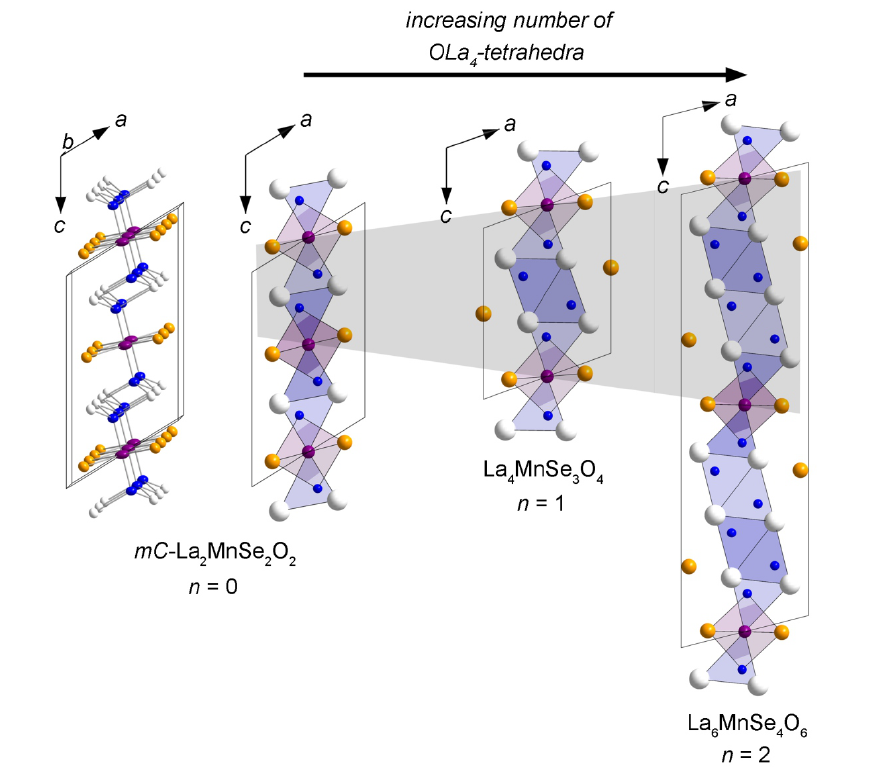
Figure 2. Crystal structures of La 2 n +2 MnSe n +2 O 2 n +2 ( n = 0–2). OLa 4 - and OLa 3 Mn-tetrahedra in blue, MnSe 4 O 2 -octahedra in violet. Rare-earth in white, manganese in violet, selenium in orange and oxygen in